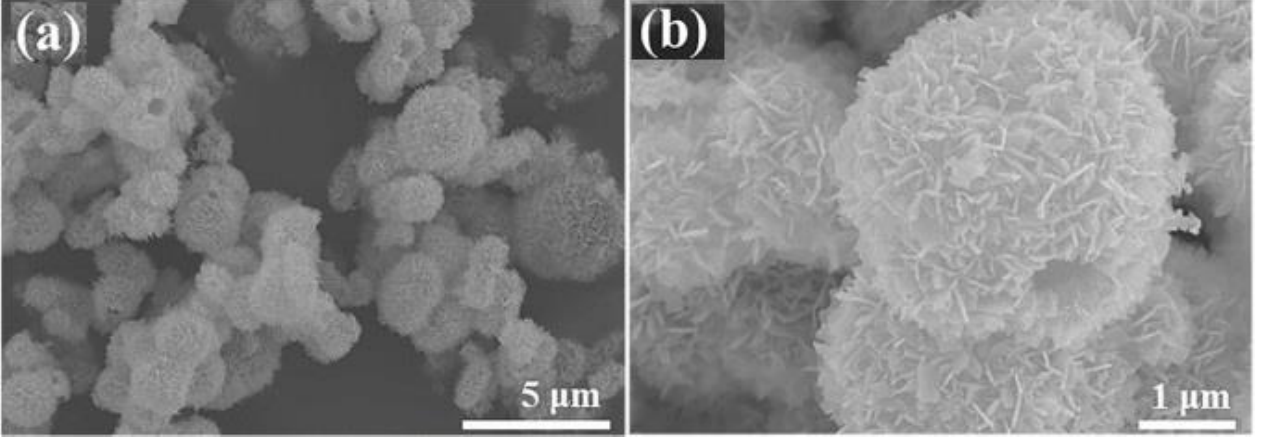
Figure 12. ( a , b ) SEM images of hierarchical CuO–WO 3 nanostructures at two different magnifications. Reprinted with permission from Ref. [116]. Copyright 2022, Elsevier.